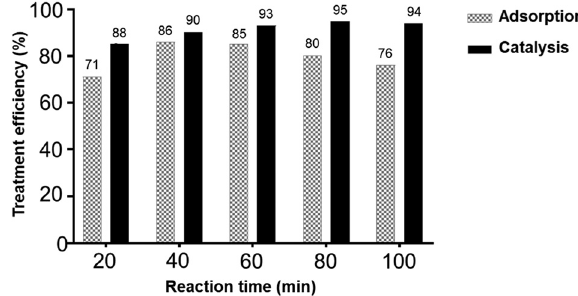
Figure 6: E ff ect of time on the DBF removal e ffi ciency. Catalysis: [ DBF ] = 30 ppm, [ H ] = 15 mM, catalyst dosage = 10 mg, room 2 O 2 temperature. Adsorption: [ DBF ] = 30ppm, adsorbent dosage = 10mg, room temperature.